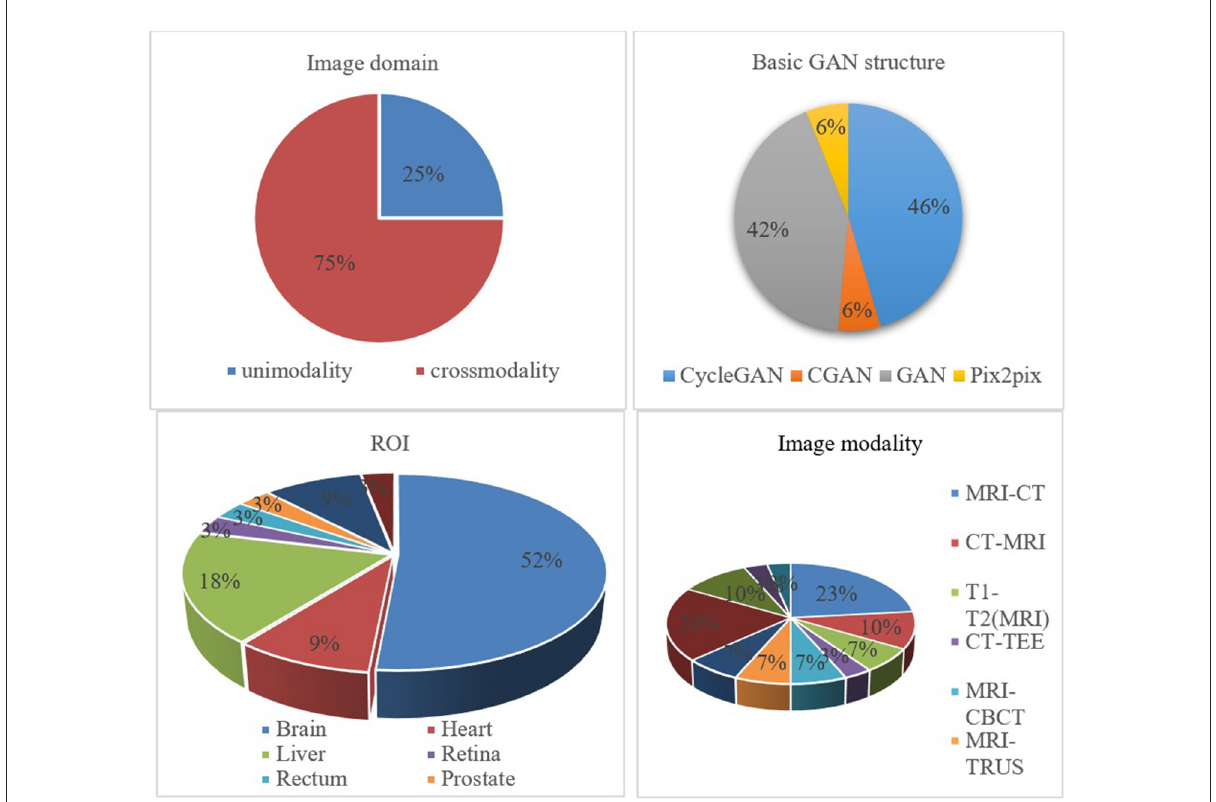
FIGURE6 Percentage pie chart of various attributes of the GAN-based biomedical image registration